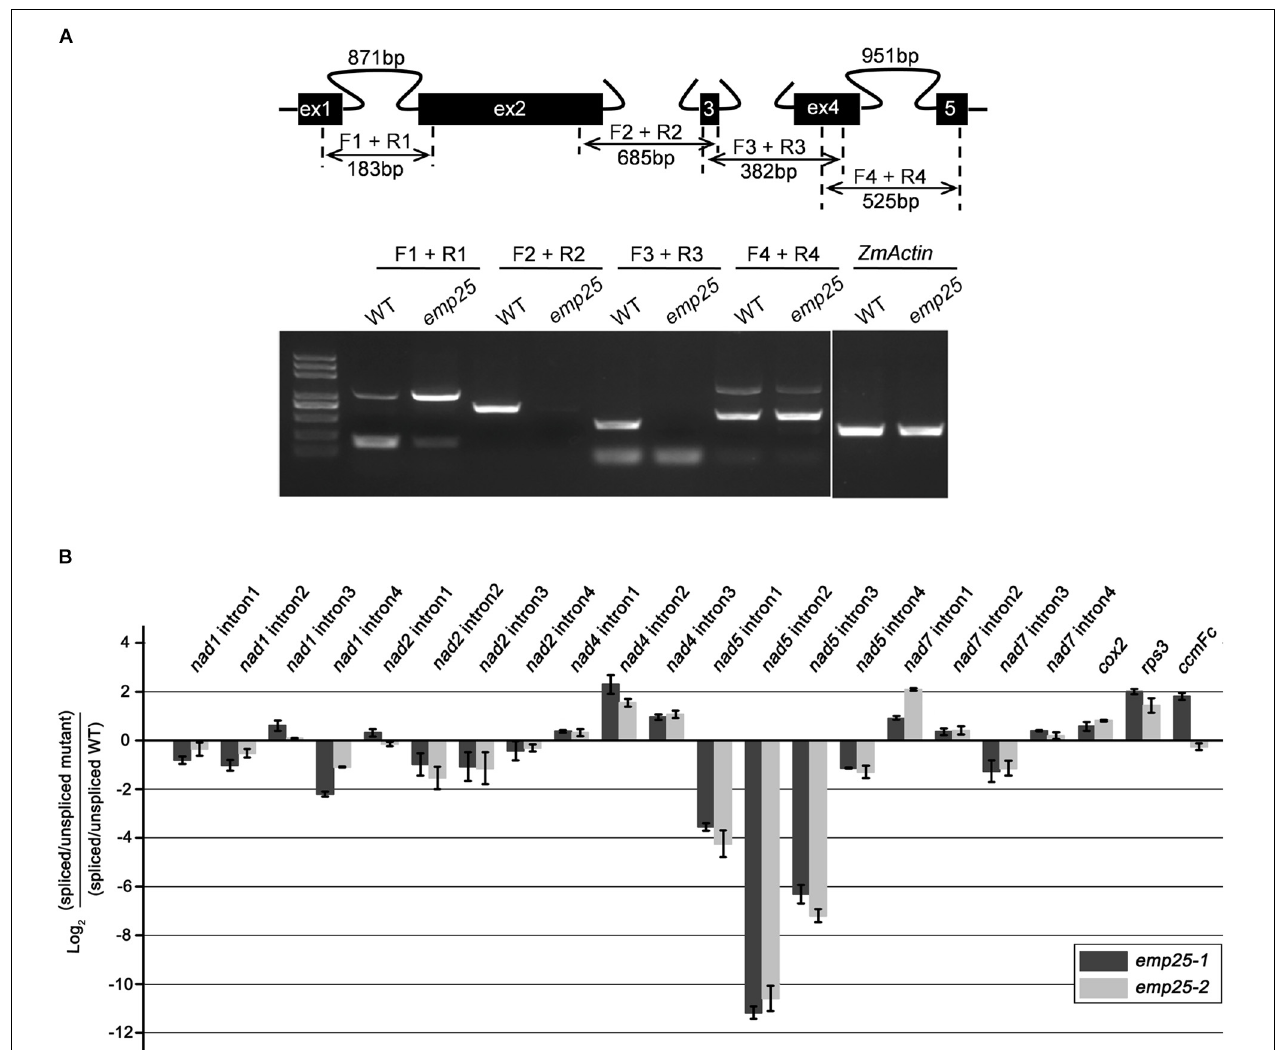
FIGURE 5 | EMP25 is required for the splicing of nad5 introns. (A) Schematic diagram of the maize mitochondrial nad5 gene and RT-PCR analysis of intron splicing efficiency in the WT and emp25 . Introns 1 and 4 are cis -splicing introns. Introns 2 and 3 are trans -splicing introns. The expected amplification products using different primer pairs are indicated. The arrows indicate the unspliced fragments of introns 1 and 4 ( cis -splicing). (B) Quantitative RT-PCR (qRT-PCR) analysis of the 22 group II intorns in maize mitochondrial genes in two alleles of emp25 . Values represent the mean and standard deviation of three biological